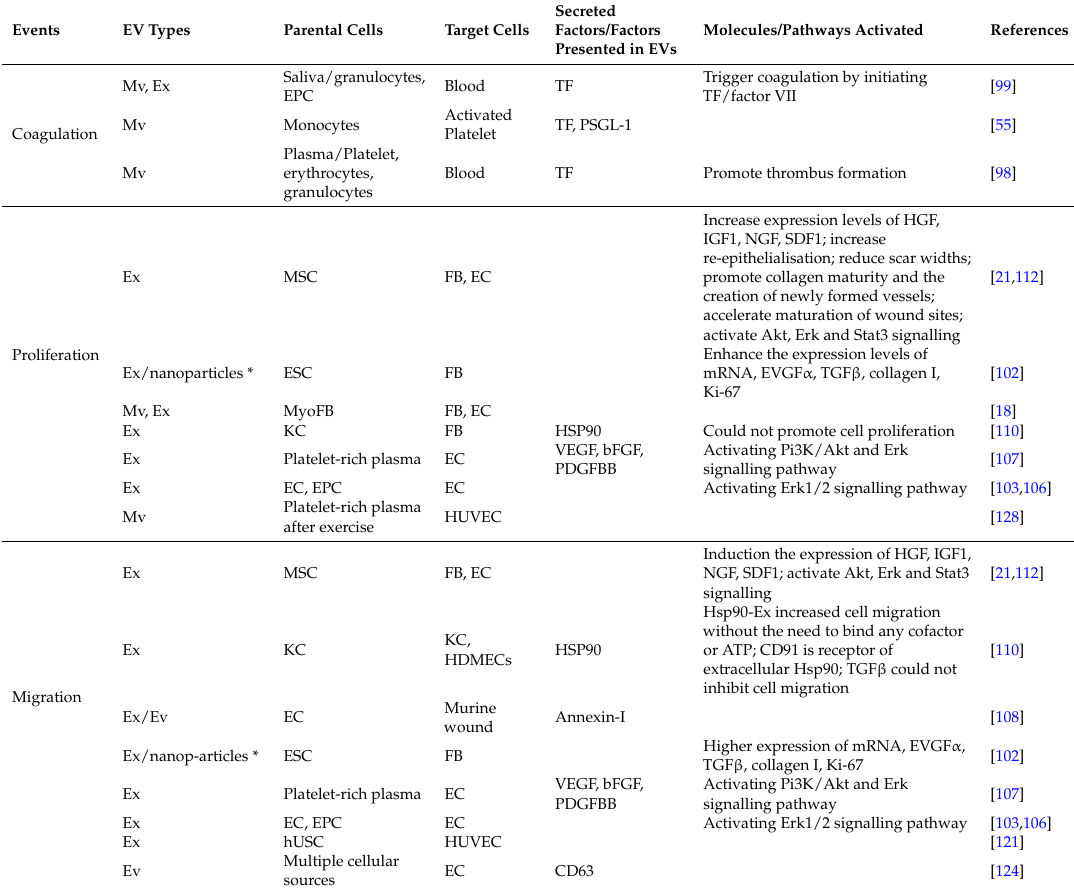
Table 1. Summary of research investigating EVs involvement in wound